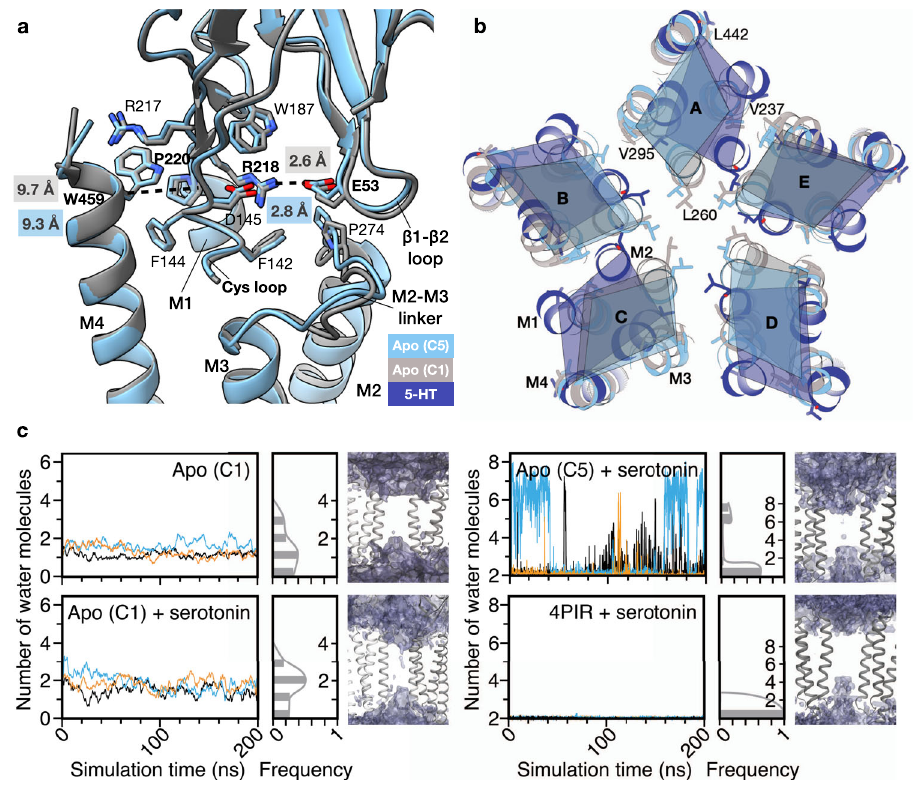
Fig. 8 Comparison of symmetric and asymmetric apo conformations. a Superposition of apo-C1 (chain C, grey) and apo-C5 5HT 3 R-Salipro (light blue) structures. Part of M1 and the Cys loop (C135-Y140) are omitted for clarity. The C α – C α distance between P220 (pre-M1) and W459 (M4) ranged between 9.6 and 9.9 Å for the individual chains. The C α – C α distance between D53 ( β 1- β 2 loop) and R218 (pre-M1) ranged between 2.5 and 3.3 Å. b Cross-section of the TMD at L260 (9 ′ position) of M2 for apo-C5, apo-C1, and serotonin-bound (dark blue) 5HT 3 R-Salipro models. Displacement measured at the C α atoms of residues on each helix in the same cross-section can be found in Supplementary Table 3. Superposition of the models that minimises the summed displacement of the indicated residues is shown. c Graphs show a number of water molecules within 4 Å of L260 at the TMD during MD simulations of apo-C1, and of apo-C1, apo-C5 (in a BPL-mimicking lipid environment) and 4PIR (in POPC) with fi ve serotonin molecules docked into the ligand-binding pockets ( + serotonin). Differently coloured lines represent the results of three simulations. Histograms show the averaged distribution of observed water molecules. Figures show water molecule densities in purple, with two subunits of each model shown in